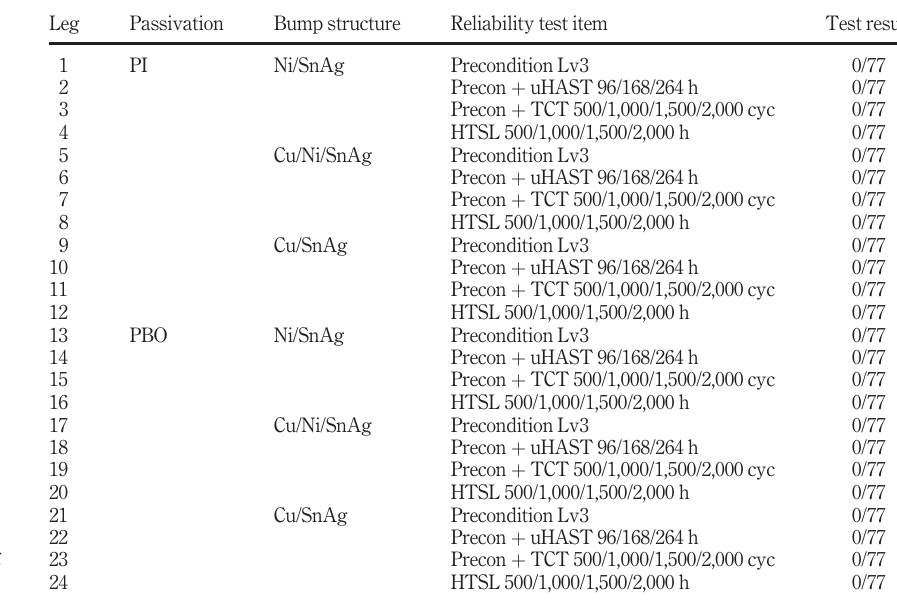
Table IV. Reliability testing matrix